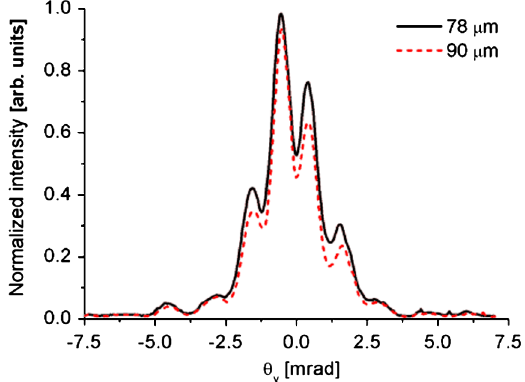
FIG. 10. Measured ODRI angular distributions for two differ- ent vertical beam sizes. The beam sizes obtained from the fit are 82 (cid:3) m and 94 (cid:3) m . Corresponding beam sizes measured by an OTR monitor are 78 (cid:3) m and 90 (cid:3) m rms, respectively. The associated angular divergences from the ODRI fit are 220 and 200 (cid:3) rad , respectively.